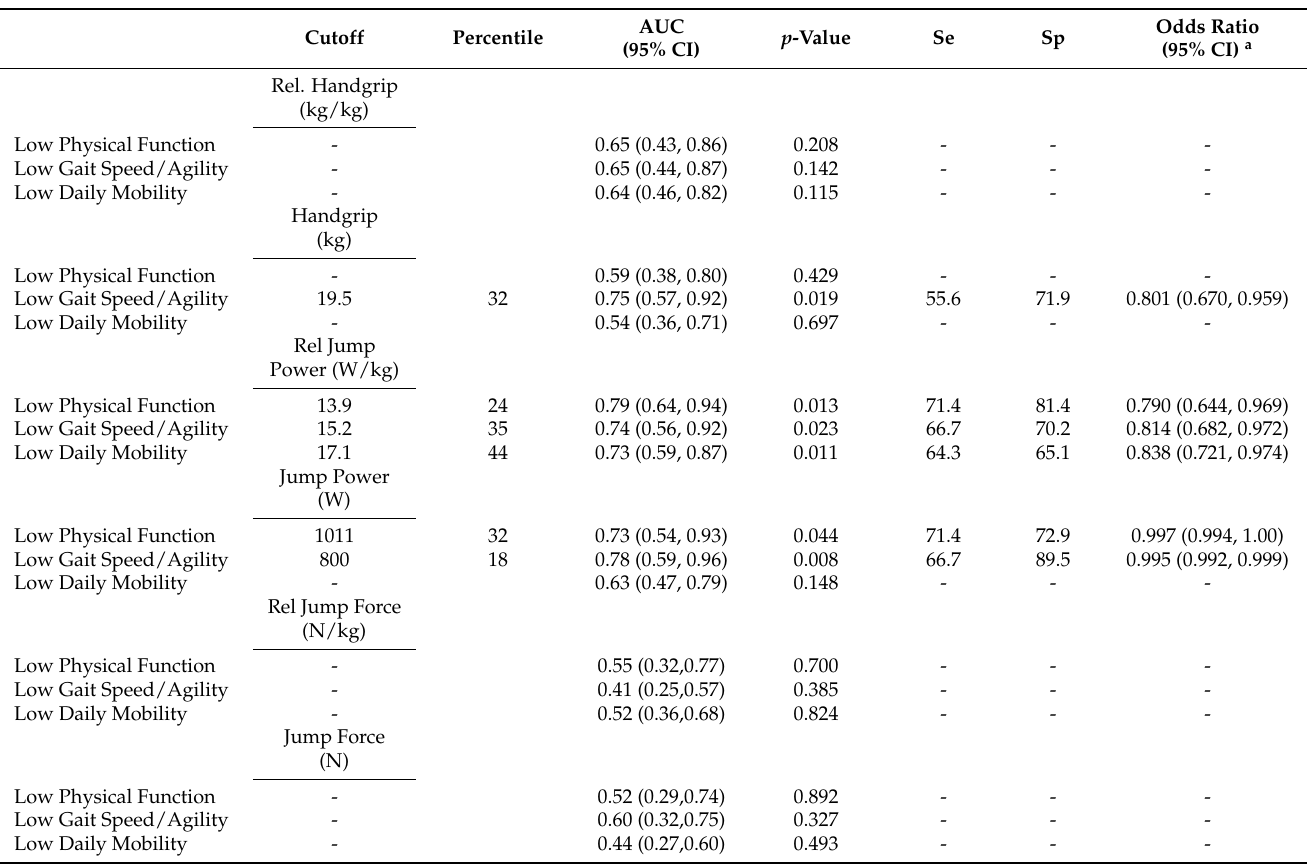
Table 3. Cutoff values for handgrip strength, vertical jump power, and vertical jump force used to identify low physical functioning expressed through CPF ( ≤ 14 pts), gait speed/agility (TUG > 8 s), and low daily mobility (PA < 4600 steps/day), classification accuracy, and respective sensitivity and specificity. Odds Ratio AUC p -Value Se Sp Cutoff Percentile (95% CI) (95% CI)